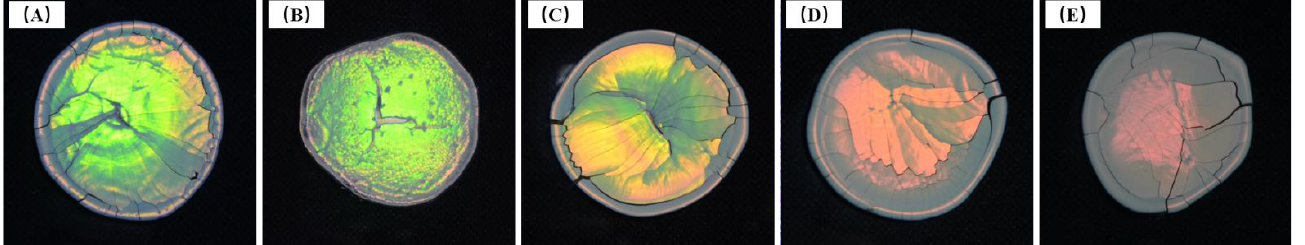
Figure 6. Photos of dried samples of P(St-AA) colloidal microspheres synthesized with different amounts of APS: ( A ) 125 mg; ( B ) 150 mg; ( C ) 175 mg; ( D ) 200 mg; ( E ) 225